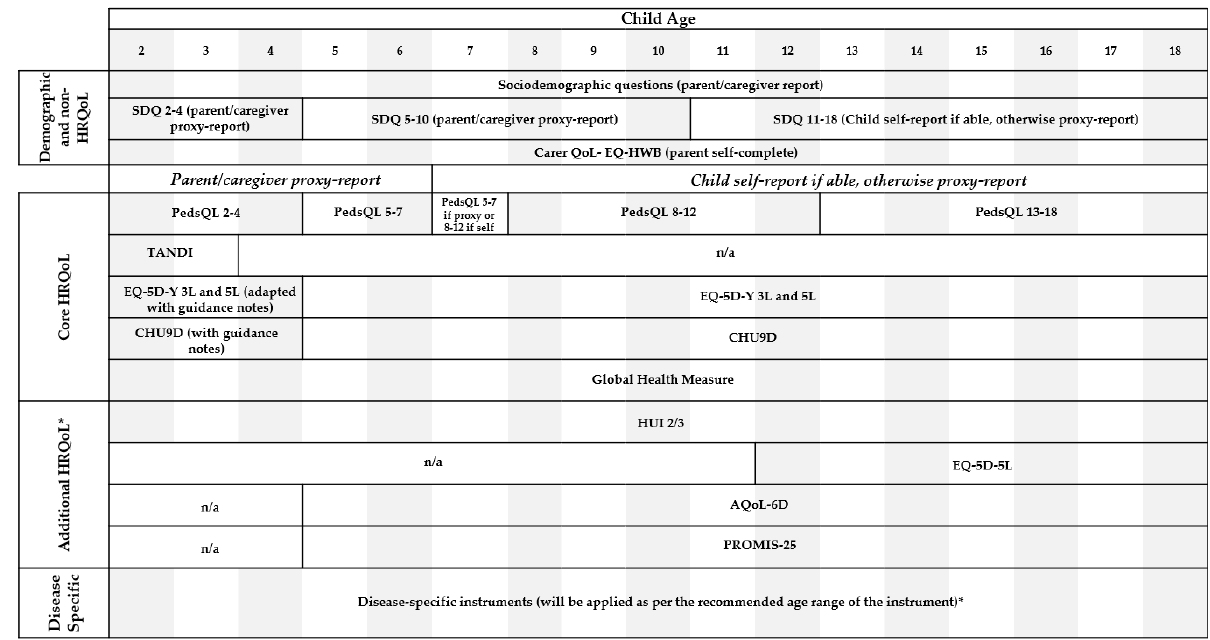
Figure 1. Summary of instruments by age. * Participant will only receive if allocated instrument based on disease group and/or randomization to receive additional instrument. Abbreviations: HRQoL health-related quality of life, SDQ Strengths and Difficulties Questionnaire, EQ-HWB EQ Health and Wellbeing Short Version, PedsQL Paediatric Quality of Life Inventory, TANDI Toddler and Infant Questionnaire, EQ-5D-Y EQ-5D Youth, CHU9D Child Health Utility, HUI2/3 Health Utilities Index Mark 2/3, EQ-5D-5L, AQoL-6D Assessment of Quality of Life, PROMIS-25 Patient-Reported Outcome Measurement Information System 25.